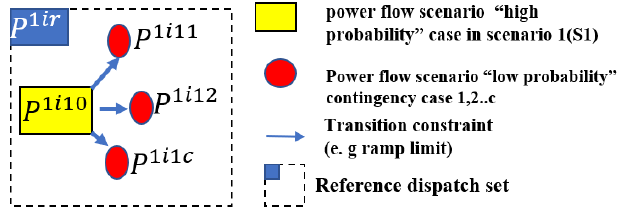
Figure 2. Typical problem structure of a single base scenario SSCED.